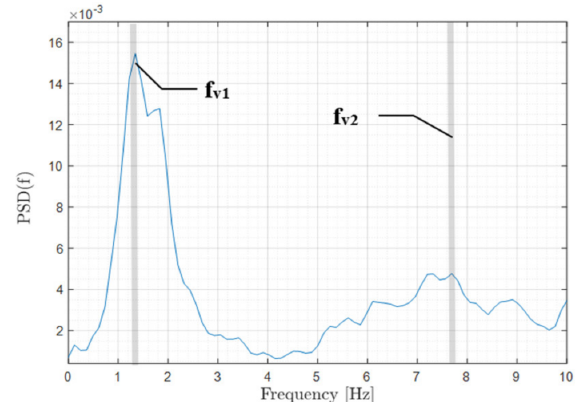
Figure 9. Auto PSD function of the vehicle response on a flat straight